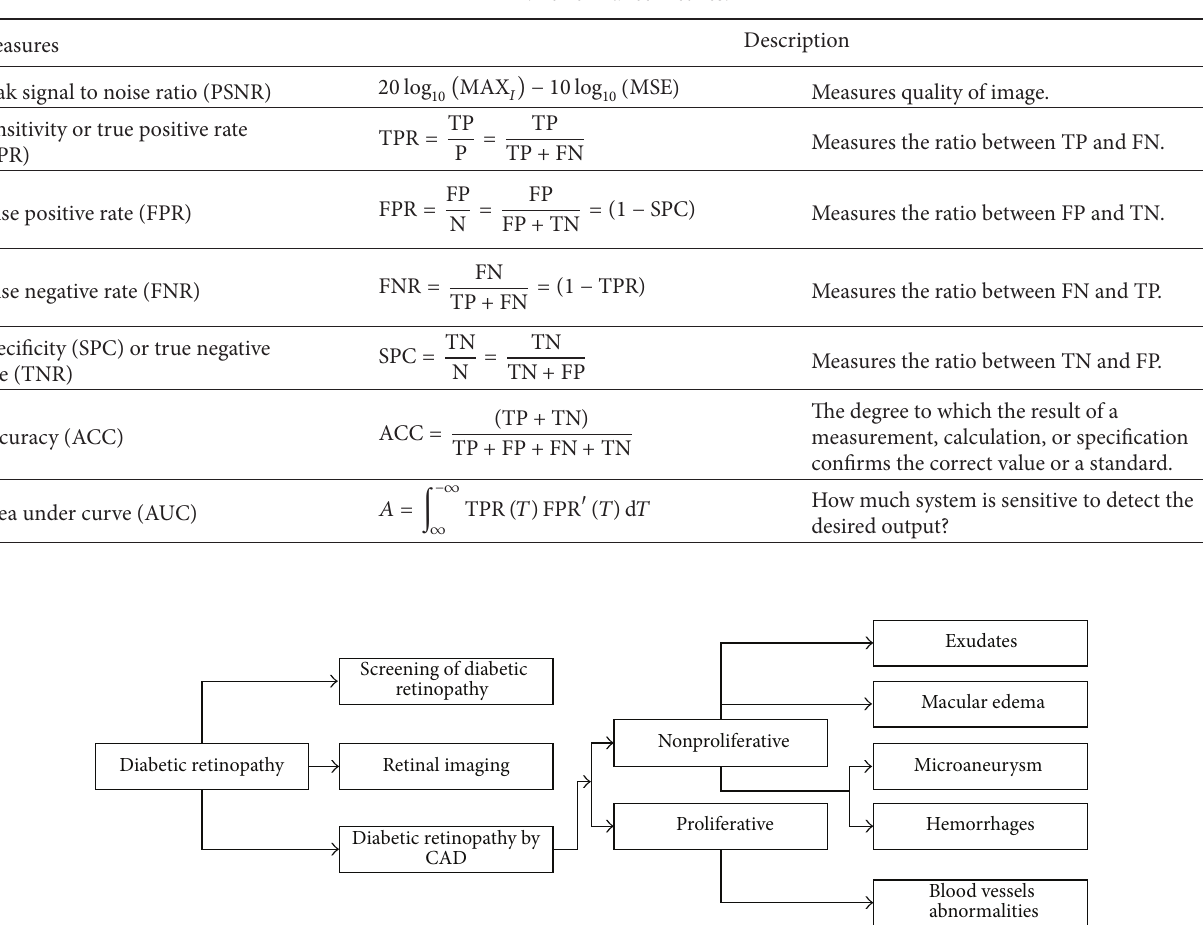
Figure 2: Methods for detection of diabetic